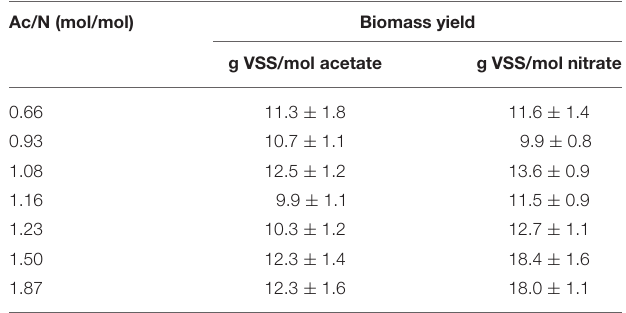
TABLE 3 | Biomass yield on acetate and nitrate for the different COD/N ratios. Ac/N